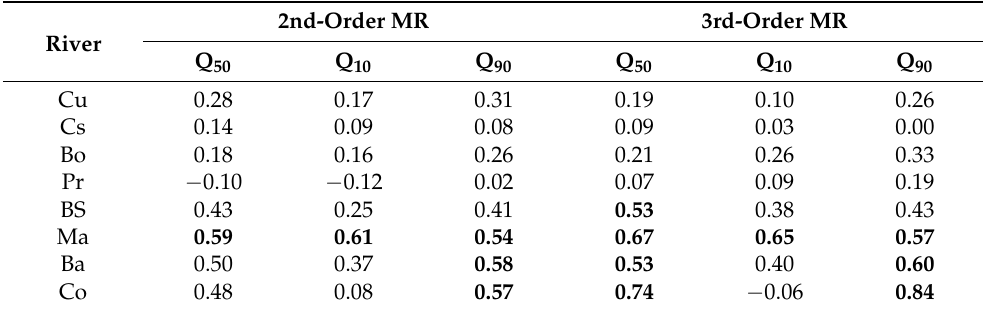
Table 3. Adjusted R 2 for the models using Niño 3.4 and DMI as predictors in SON a set. The values higher than 0.5 are bolded, indicating good model